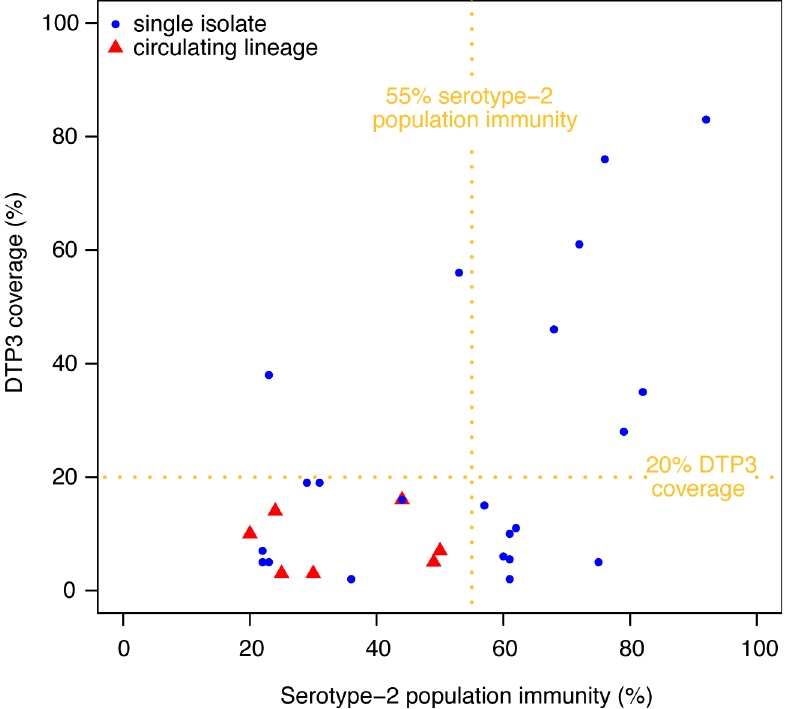
Fig 5. Risk factors for an emergent VDPV2 to establish a circulating lineage associated with > 1 case of poliomyelitis in Nigeria. Serotype-2 population immunity and DTP3 coverage in districts in the 6-month period when the first AFP case associated with each of the 29 independent VDPV2 emergences in Nigeria during 2004 − 2014 were reported. Red triangles represent isolates that established circulating lineages, whereas blue circles represent single